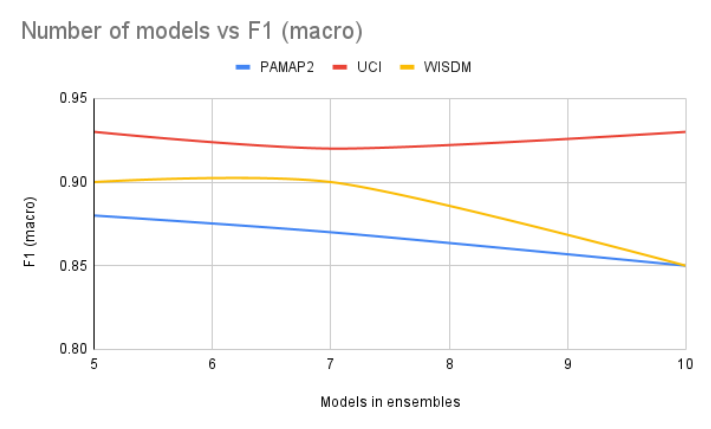
Figure A9. Number of models (along x -axis) versus F1 (macro) (along y -axis)